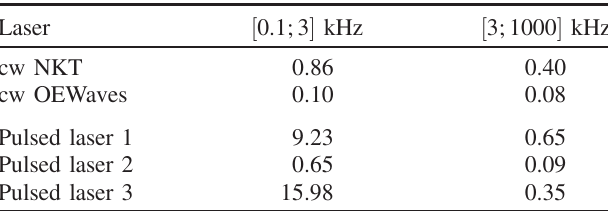
TABLE III. Values of the integrated rms frequency jitter on the two defined ranges for the different lasers